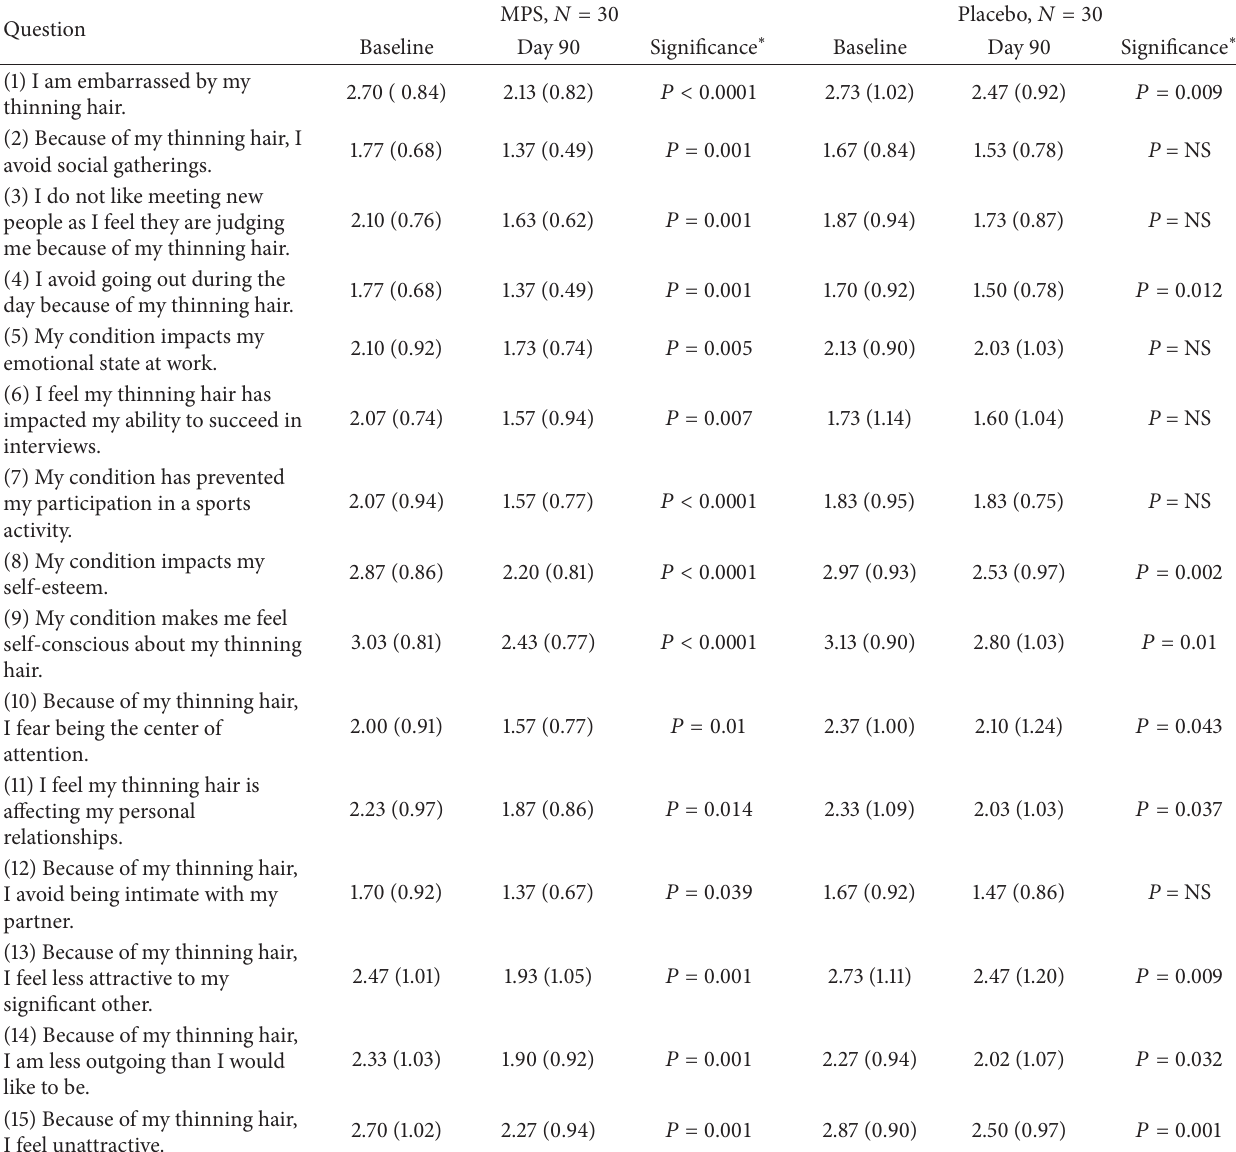
Table 3: Quality of Life Questionnaire